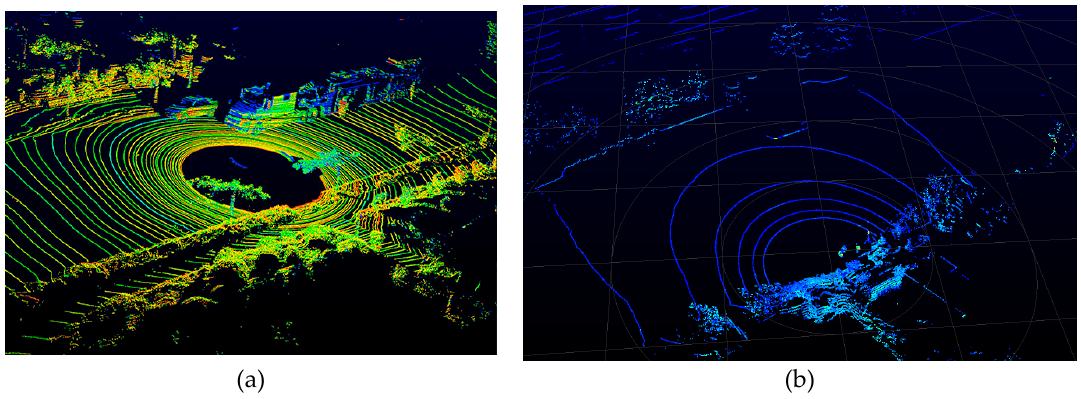
Figure 1. Cloud points from roadside cost ‐ efficient LiDAR sensor. ( a ) Relative high ‐ density LiDAR cloud points (64 beams). ( b ) Relative low ‐ density LiDAR cloud points (16 beams).